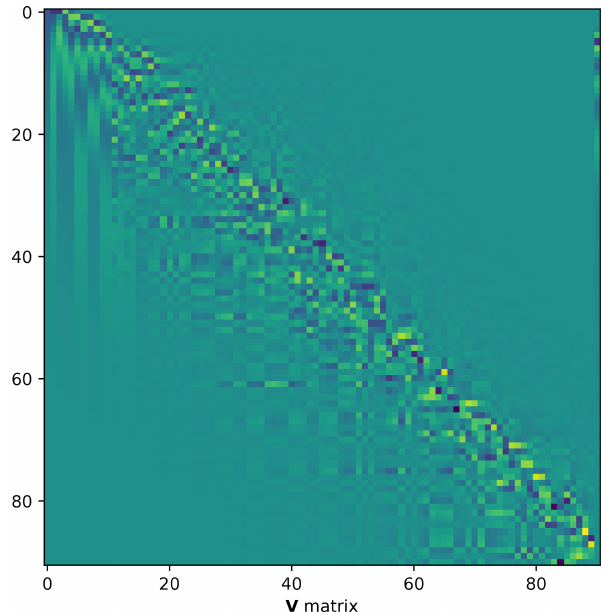
Figure 5. Image representation of the V matrix. The first 11 columns show non-noise structures. These are shown in Fig. 6 with scale information